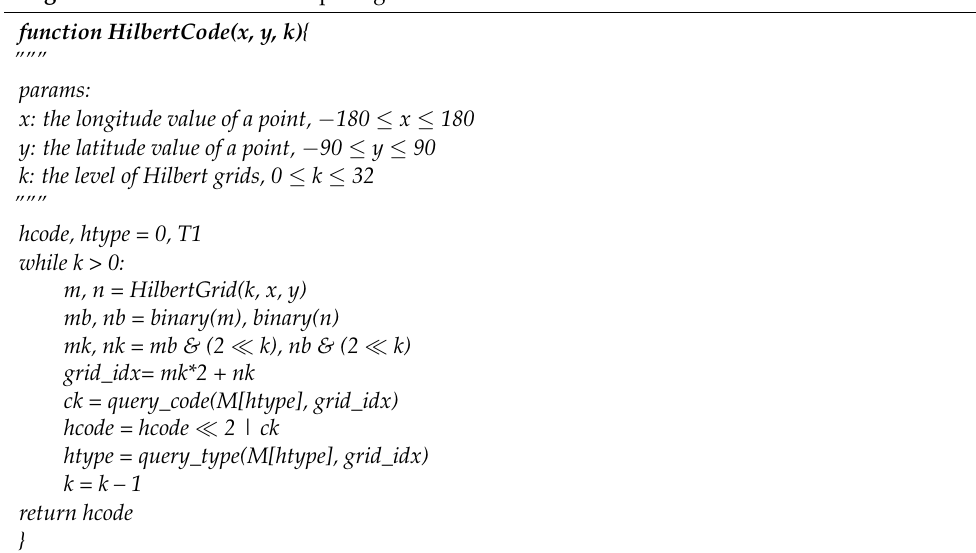
Figure 7. Transition matrixes for Hilbert curves.